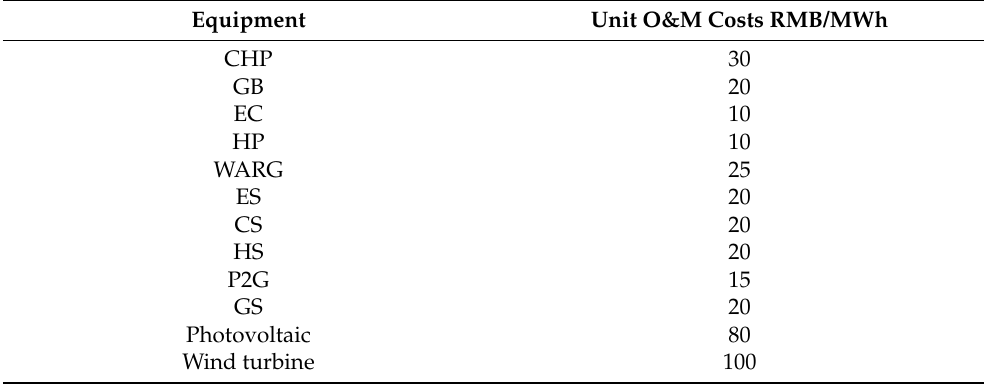
Table 1. Operation and maintenance cost factors for each